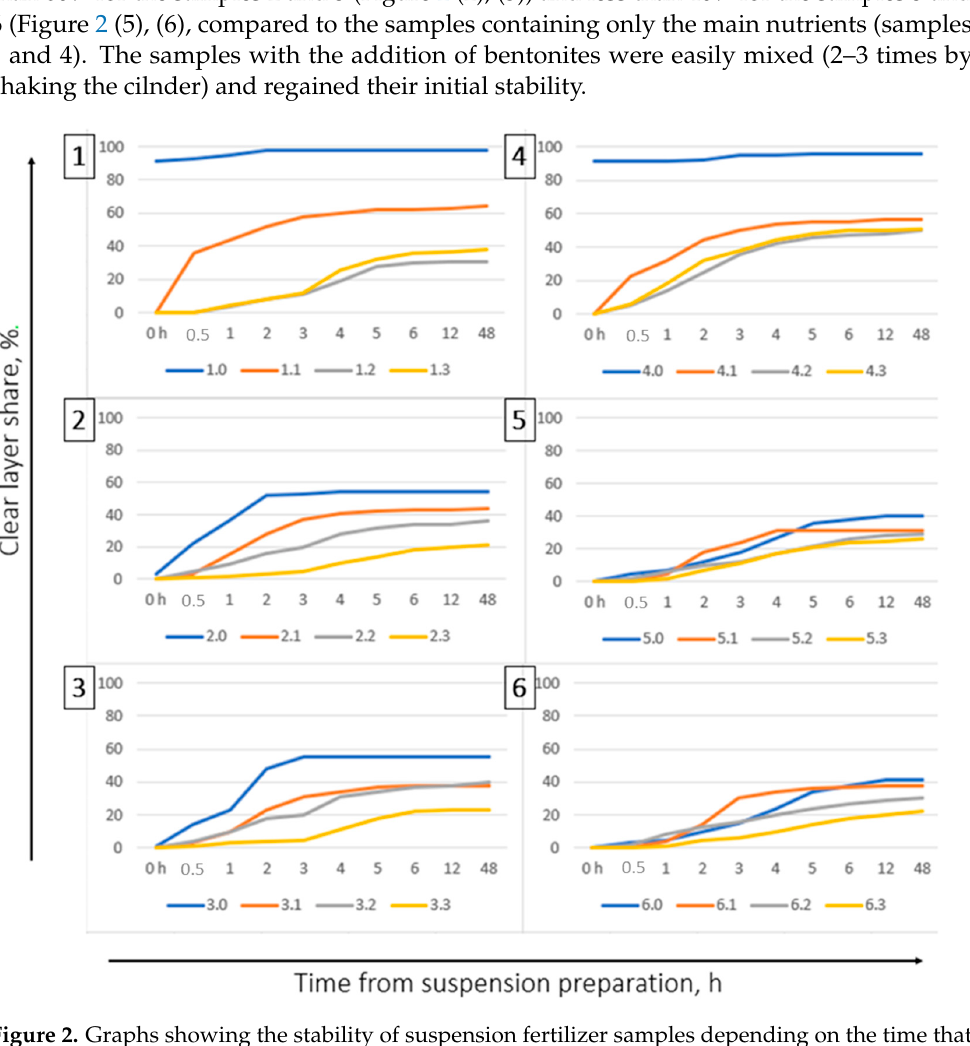
Figure 2. Graphs showing the stability of suspension fertilizer samples depending on the time that has elapsed since their production. Each graph concerns one type of fertilizer (1–6) in the variants of the addition of various bentonites.